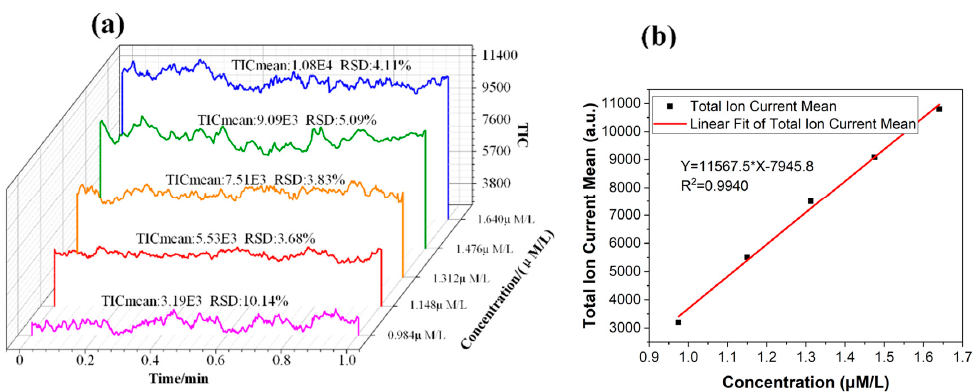
Figure 6. ( a ) The intensity signal of the reserpine solution with di ff erent concentrations. ( b ) The relationship between the concentration of the solution and the total ion current mean. TIC, total ion